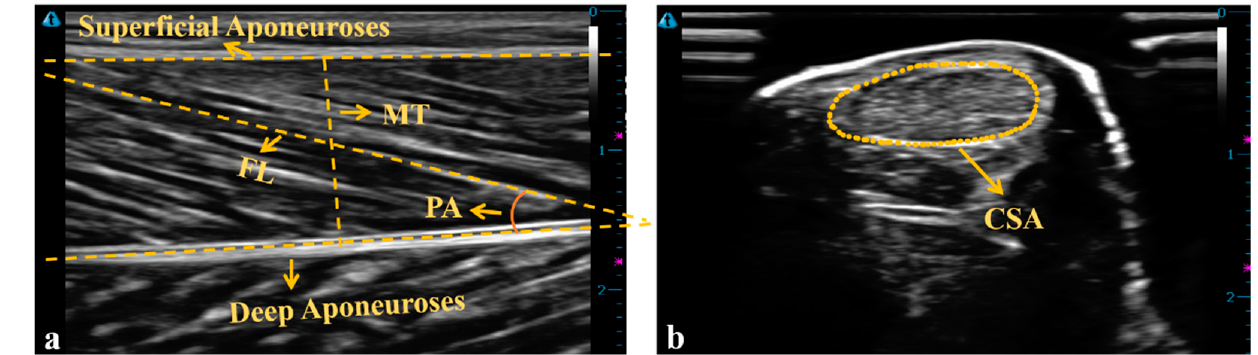
Figure 3. ( a ) The ultrasound image of MG. ( b ) The ultrasound image of the AT’s CSA.